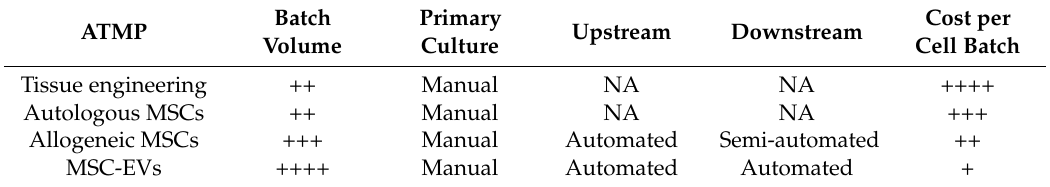
Table 1. Production process parameters characteristic for different advanced therapy medicinal products